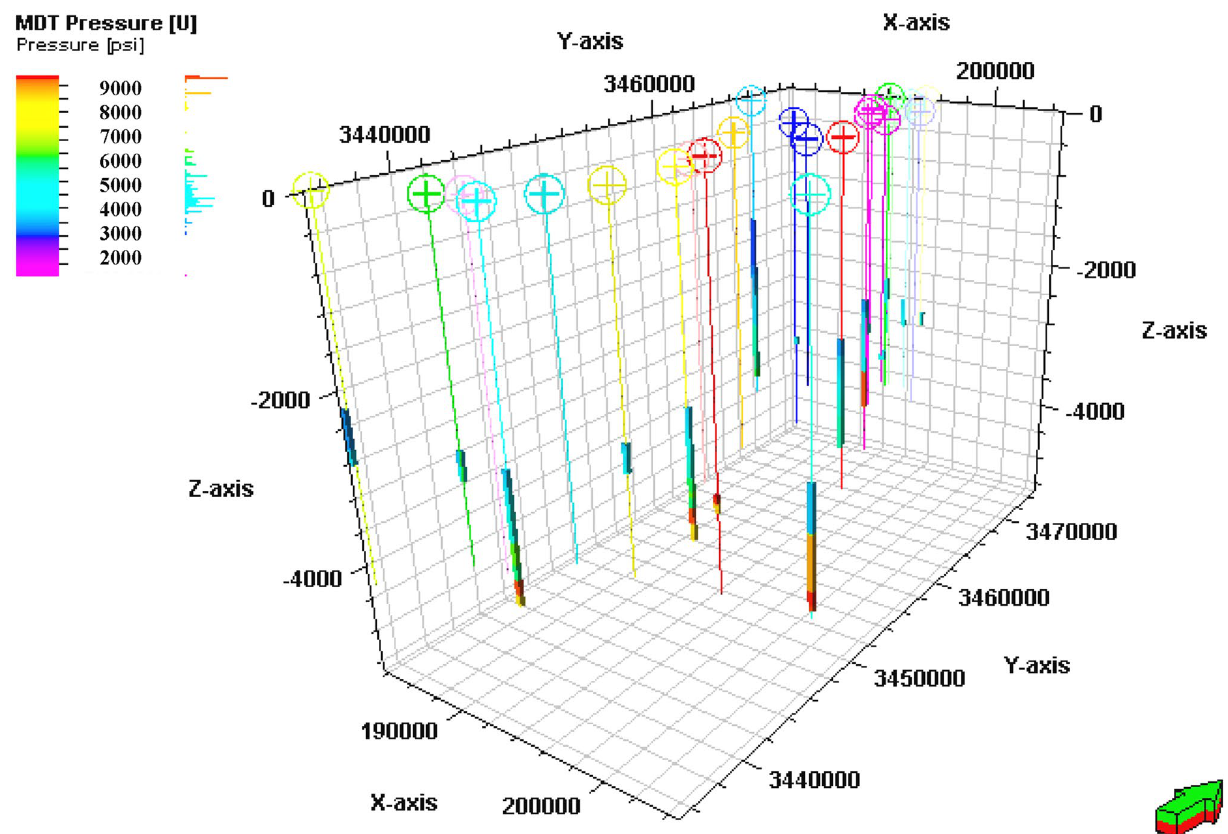
Fig. 6 Initial scale-up effective pressure model resulting from MDT well logging data and DST pressure